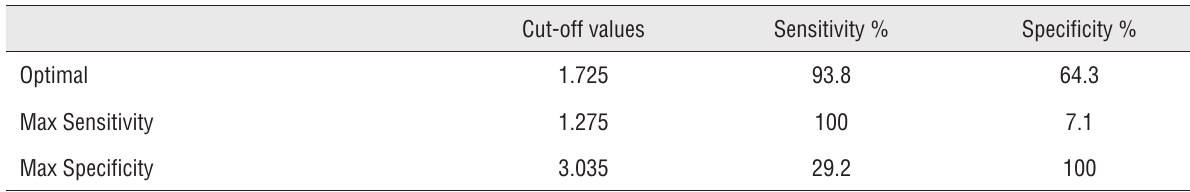
Table 2 - cut-off values of NLR for malignancy.